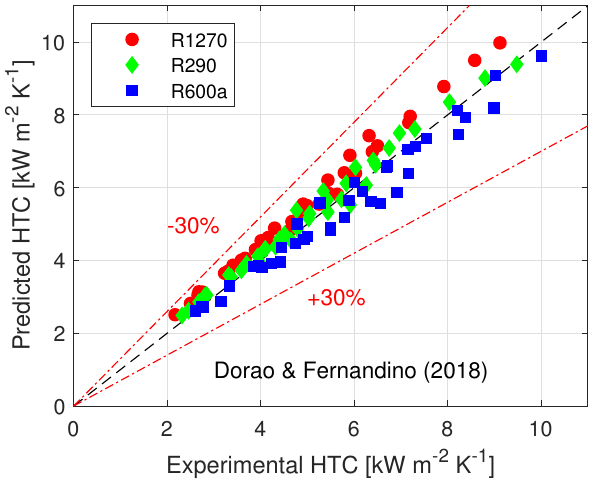
Figure 13. Comparison between experimental data and correlations of Dorao and Fernandino [35] for prediction of HTC in smooth tubes.